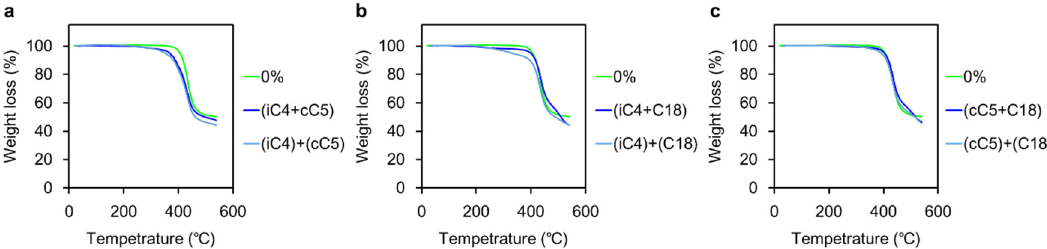
Figure 1. TGA profiles of the PF hybrids in the absence and presence of: ( a ) 40 wt % (iC4 + CP)POSS and the mixture with 20 wt % iC4-POSS and 20 wt % CP-POSS; ( b ) 40 wt % (iC4 + C18)POSS and the mixture with 20 wt % iC4-POSS and 20 wt % C18-POSS; and ( c ) 40 wt % (CP + C18)POSS and the mixture with 20 wt % CP-POSS and 20 wt % C18-POSS.